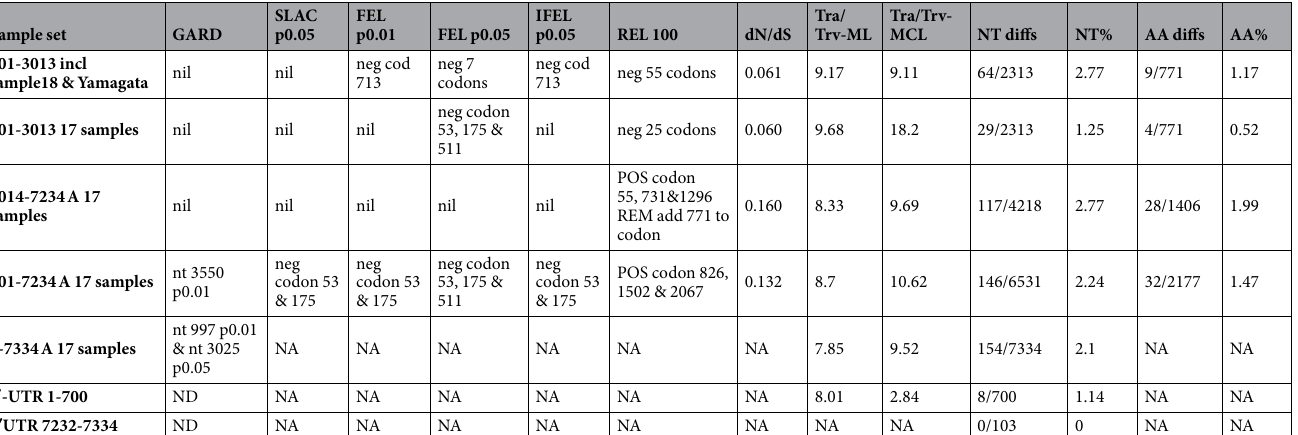
Table 2. Information about the sequence datasets analysed. The sample sets and results of various types of analyses are shown; see Materials and Methods and Results and Discussion sections for details. Tra/Trv is the transition/transversion bias. Nucleotide (NT) and amino acid (AA) sites with differences within each dataset are also